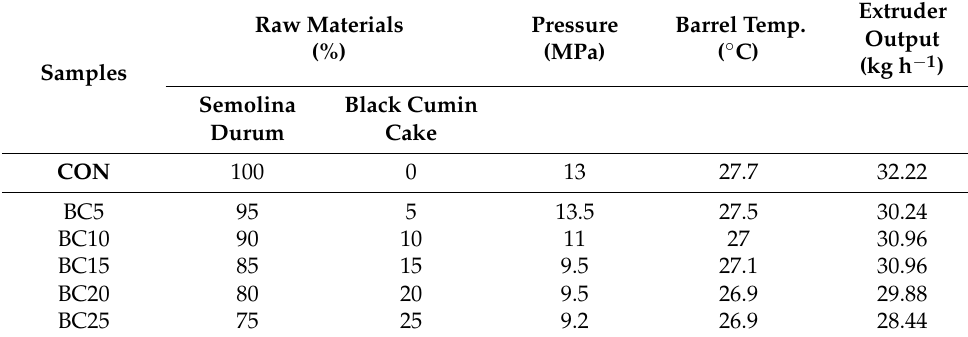
Table 1. Model of the